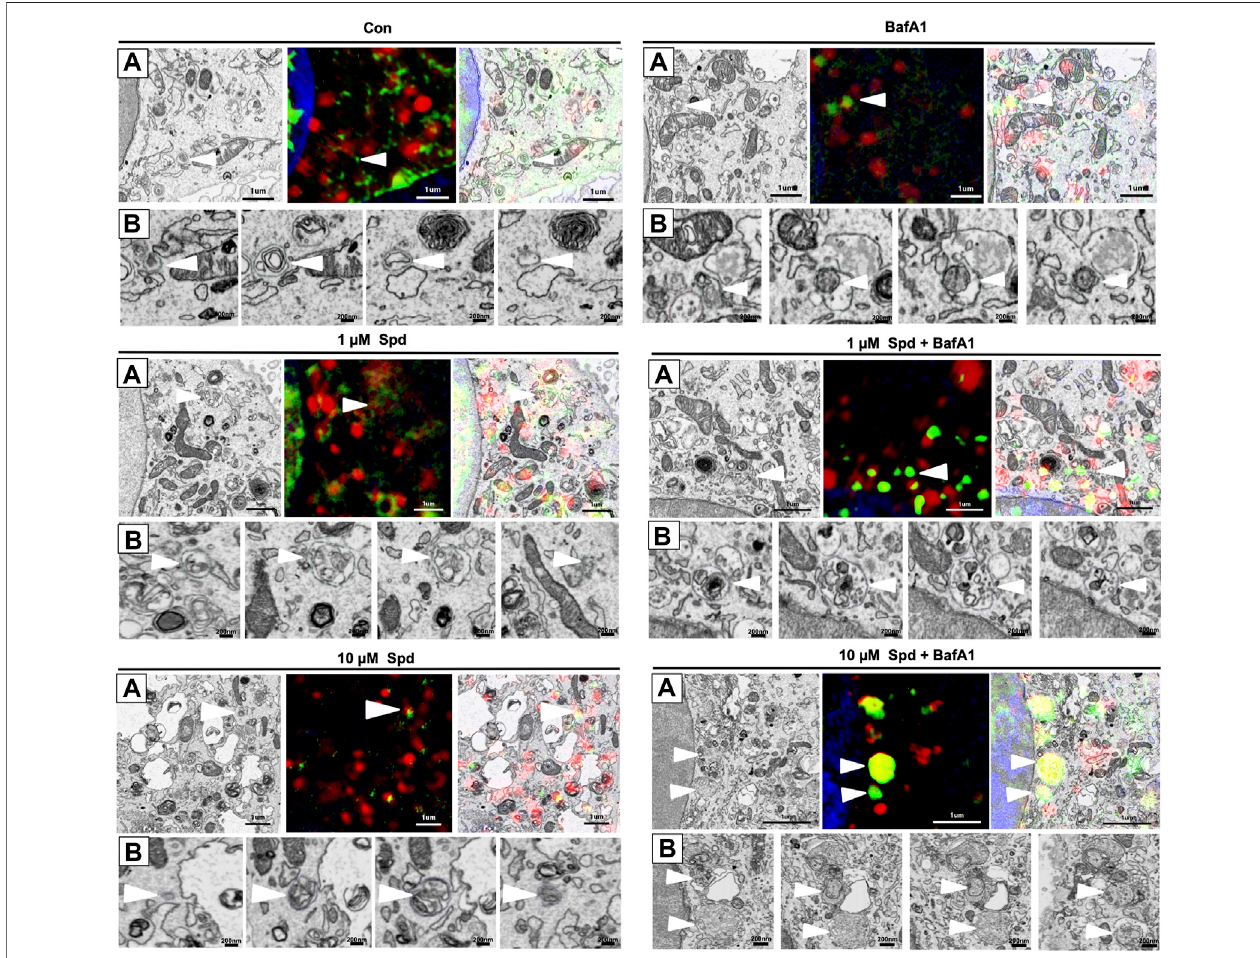
FIGURE 5 | Differential response in cargo selection upon treatment. (A) Selective region of interest indicating autophagosome (white arrow heads) in FIB-SEM (Left), SR-SIM (middle) and CLEM (right) for the control (untreated) group, 1 μ M Spd, 1 μ M Spd + BafA1, 10 μ M Spd and 10 μ M Spd + BafA1. (B) FIB-SEM micrograph showingdistinctcargocontainedwithintheautophagosome(whitearrowheads)followingtreatments.10 μ MSpd+BafA1treatedgrouprecruitscargocharacterisedby the abundance of small intra-autophagosomal vesicle-like structures of homogeneous electron density. Scale bar: 1 μ m and 200 nm.